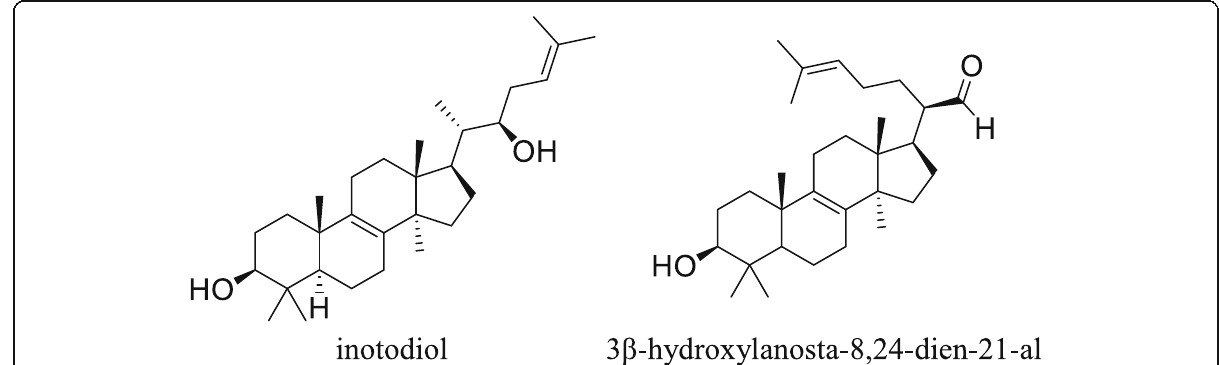
Fig. 1 Chemical structure of inotodiol and 3 β